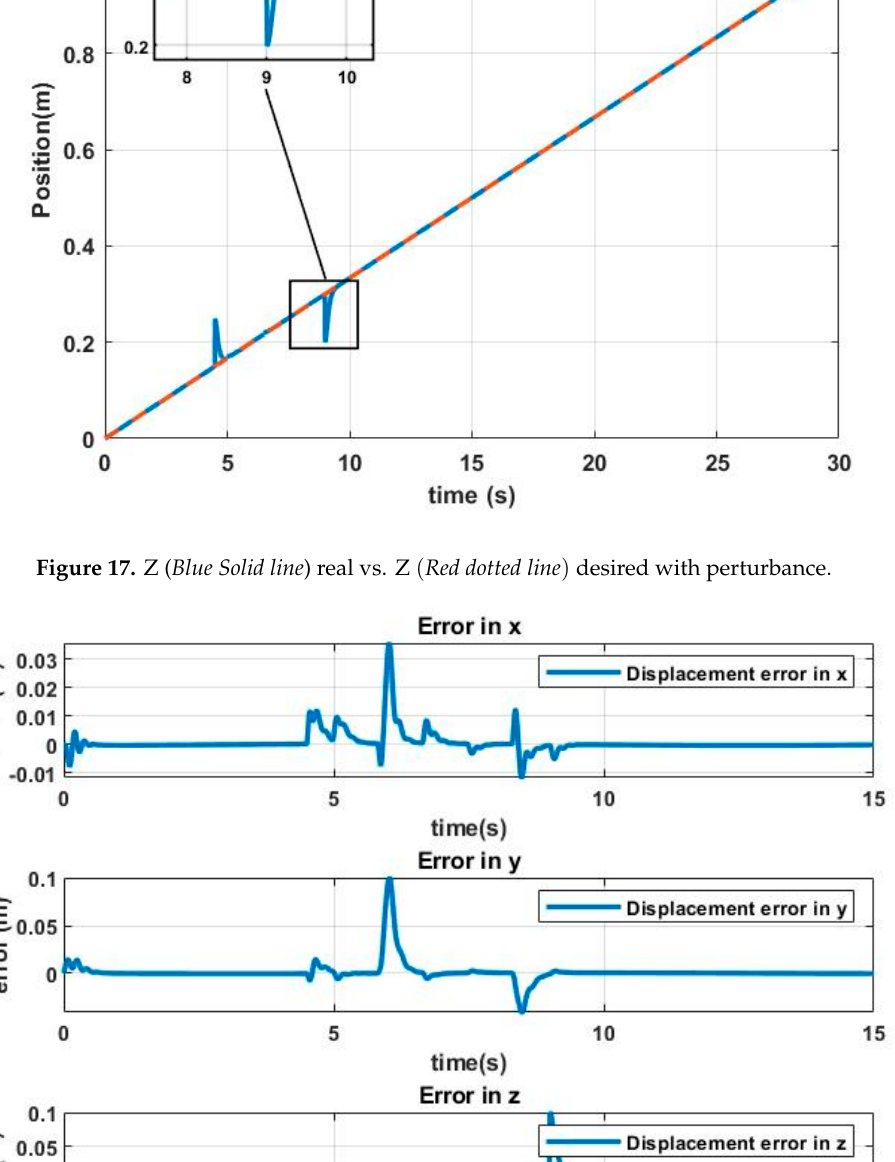
Figure 16. Y ( 𝐵𝑙𝑢𝑒 𝑆𝑜𝑙𝑖𝑑 𝑙𝑖𝑛𝑒 ) real vs. Y (𝑅𝑒𝑑 𝑑𝑜𝑡𝑡𝑒𝑑 𝑙𝑖𝑛𝑒) desired with perturbance.